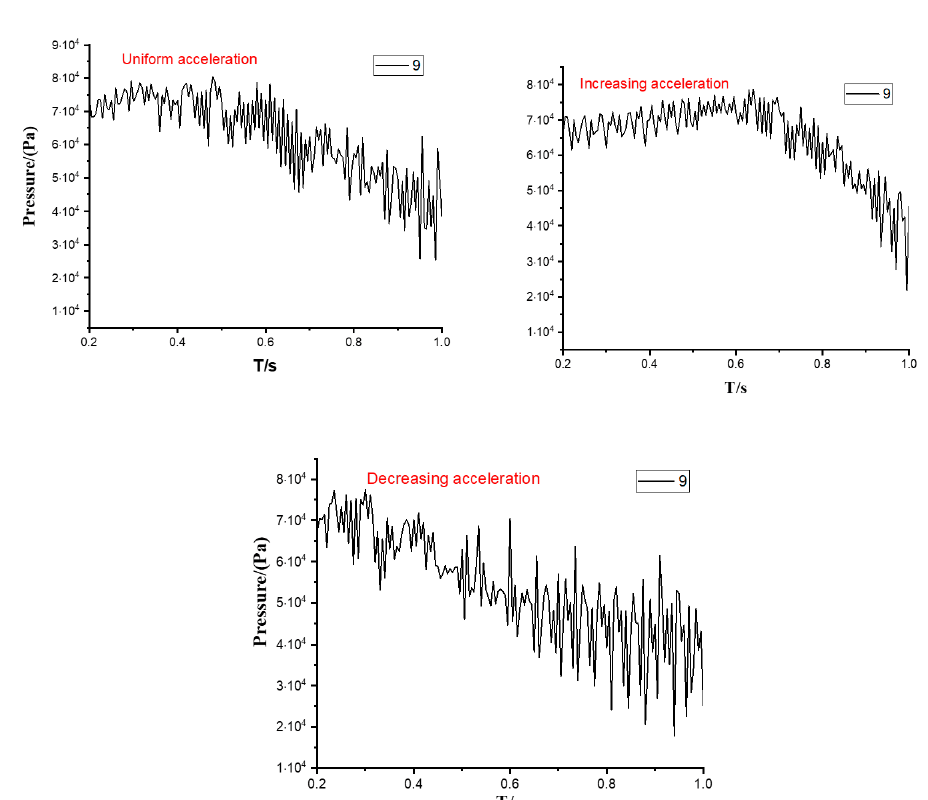
Figure 13. Cavitation pressure distribution at guide vane.